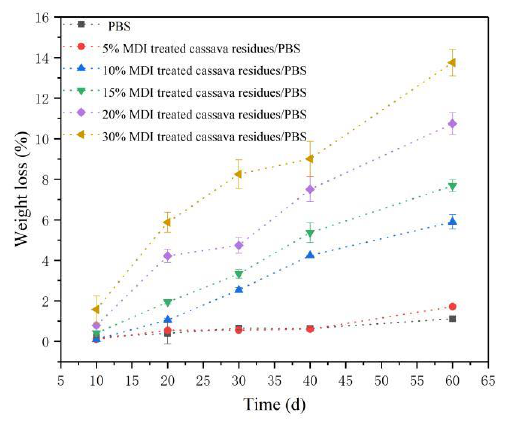
Figure 9. Weight loss of pure PBS and MDI-modified cassava residues/PBS composite.